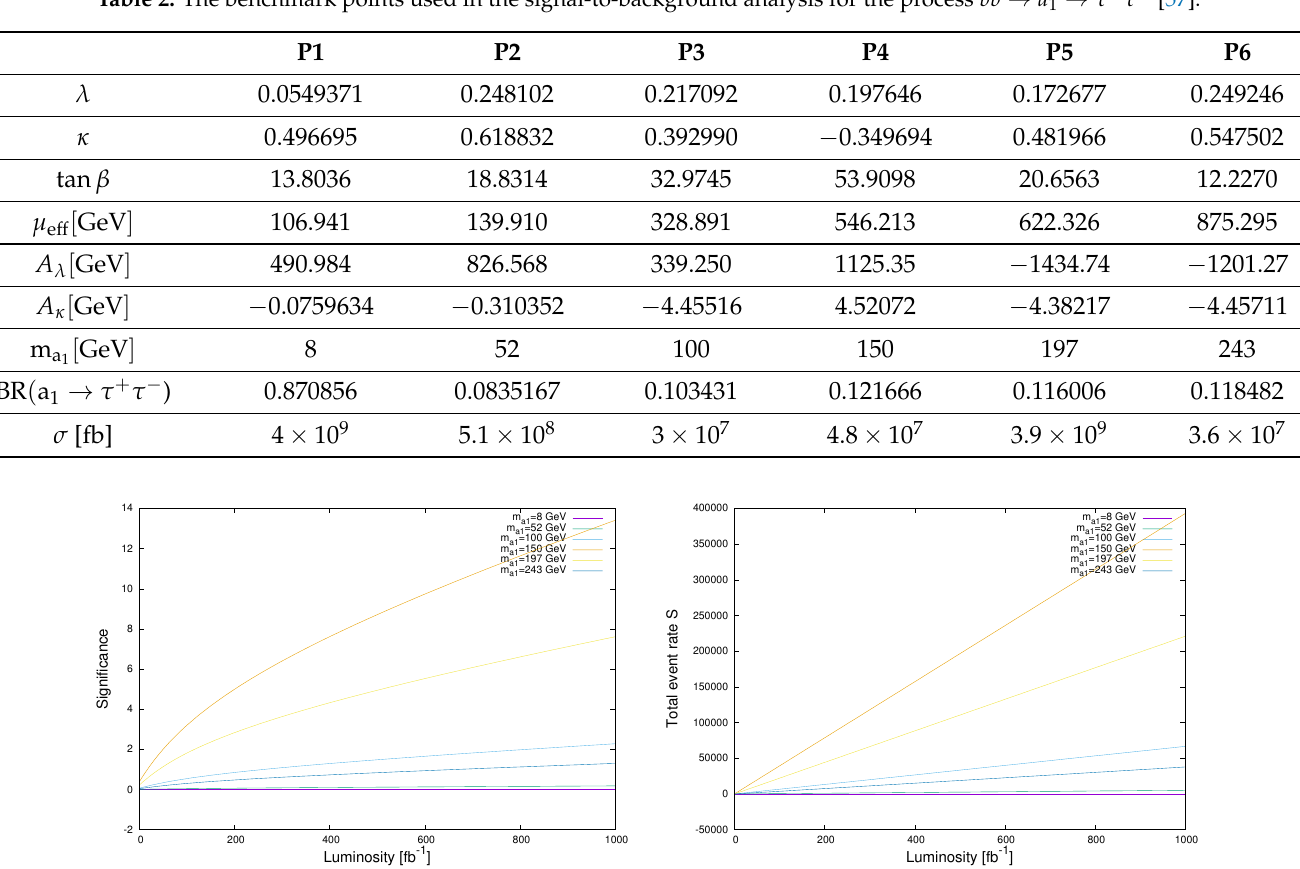
√ B ( left plot ) and the total event rate S ( right plot ) of the production process b ¯ b → a 1 → τ + τ − as Figure 7. The signal significance S / functions of the integrated luminosity for the six benchmark points mentioned in Table